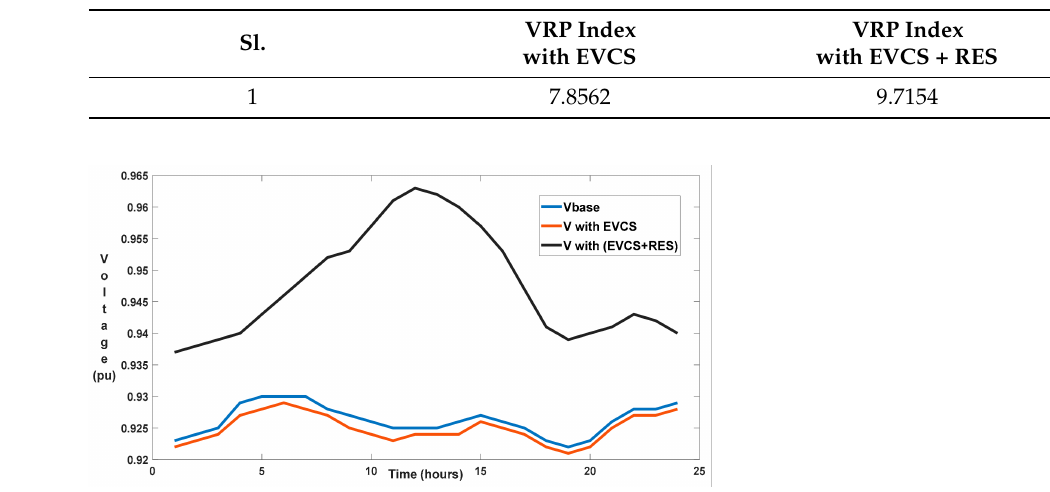
Figure 13. Voltage profile of 33-bus system for 24 h.